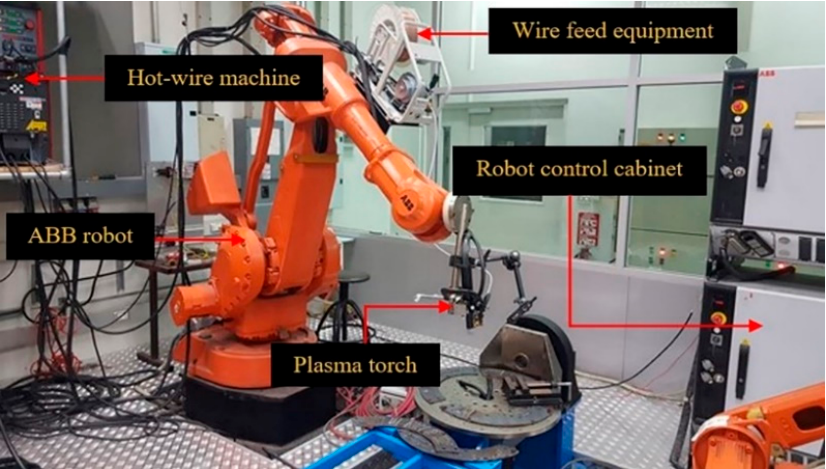
Figure 1. Setup of the hot-wire plasma welding for the additive manufacturing (AM) process sys- tem.